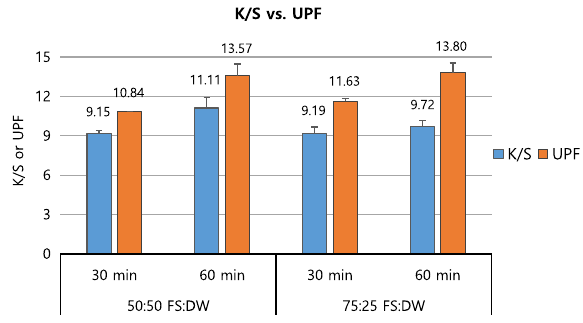
Fig. 9 Comparison of color strength (K/S) and UV